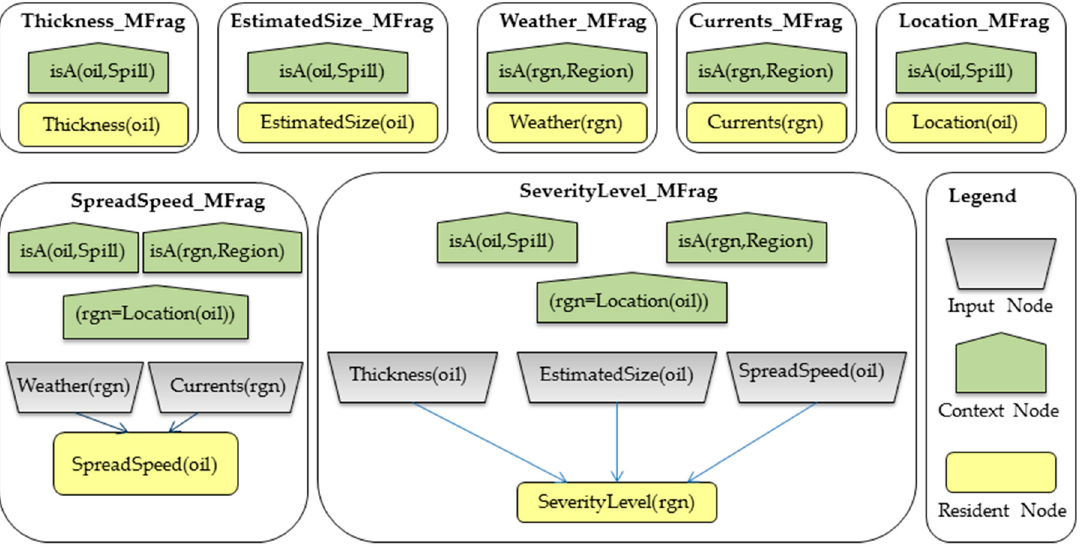
Figure 6. The Multi-Entity Bayesian Network (MEBN) model to reason about the severity level of spills.